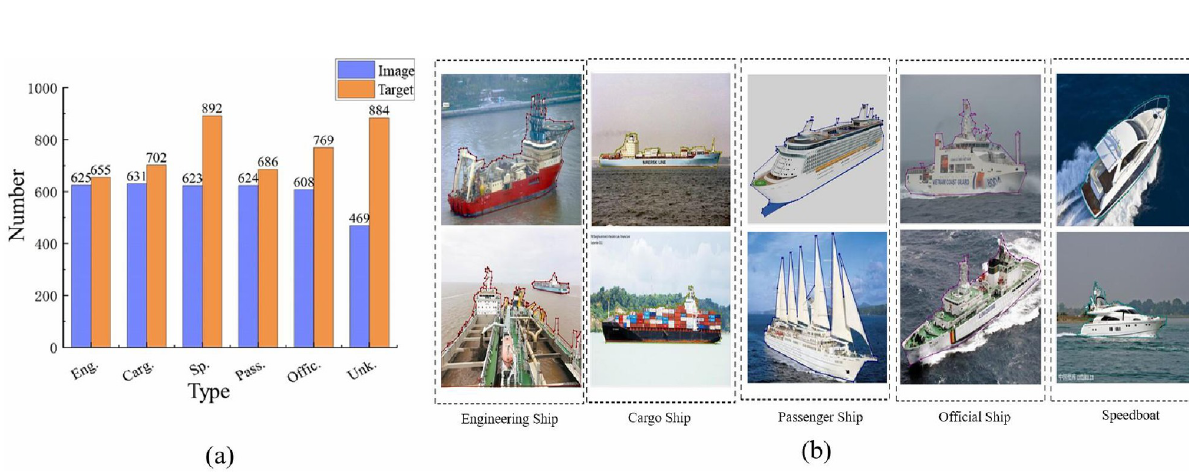
Fig 6. The MariBoatsSubclass dataset. (a) The histogram of the number of images and labelled ships in individual categories in MariBoatsSubclass. (b) Delineations of representative images of each category in MariBoatsSubclass.